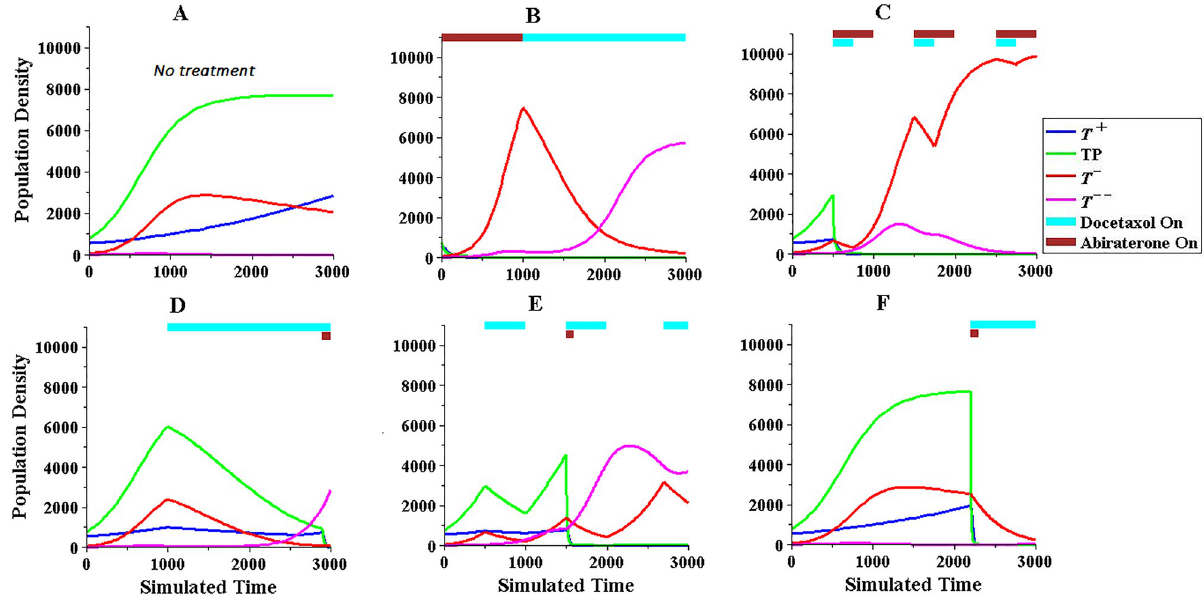
Fig 1. Comparison of some treatment methods on cell population dynamics in responder group with best result shown in 1F.